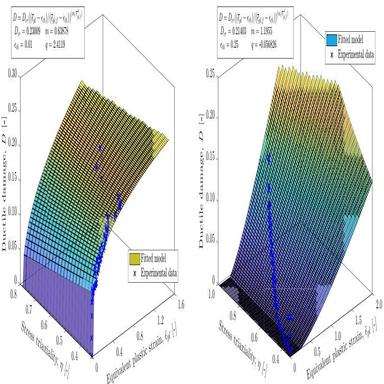
Experimental ductile damage as a function of equivalent plastic strain and stress triaxiality data fitted to the proposed damage accumulation model: (a) stainless steel 304L; (b) copper C110.